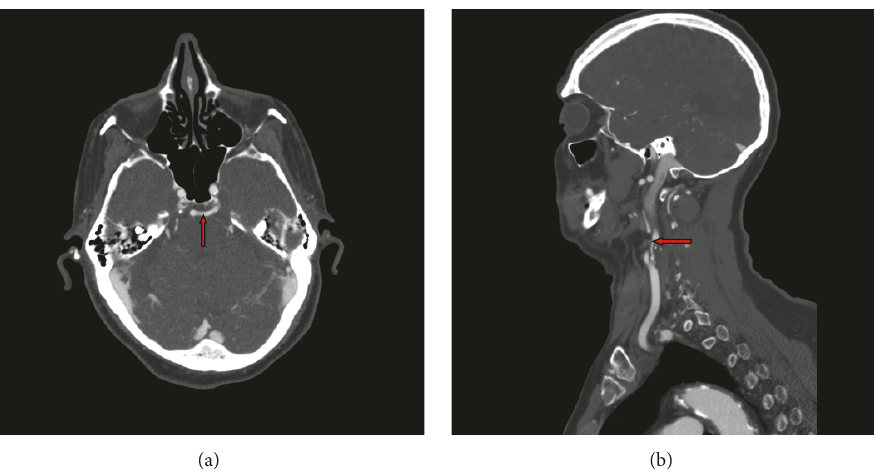
Figure 1: (a) A CT angiogram showing a persistent trigeminal artery arising from the left cavernous internal carotid artery and supplying the mid-distal basilar artery (red arrow). (b) A CT angiogram of the neck revealing the severely stenosed left internal carotid artery (red